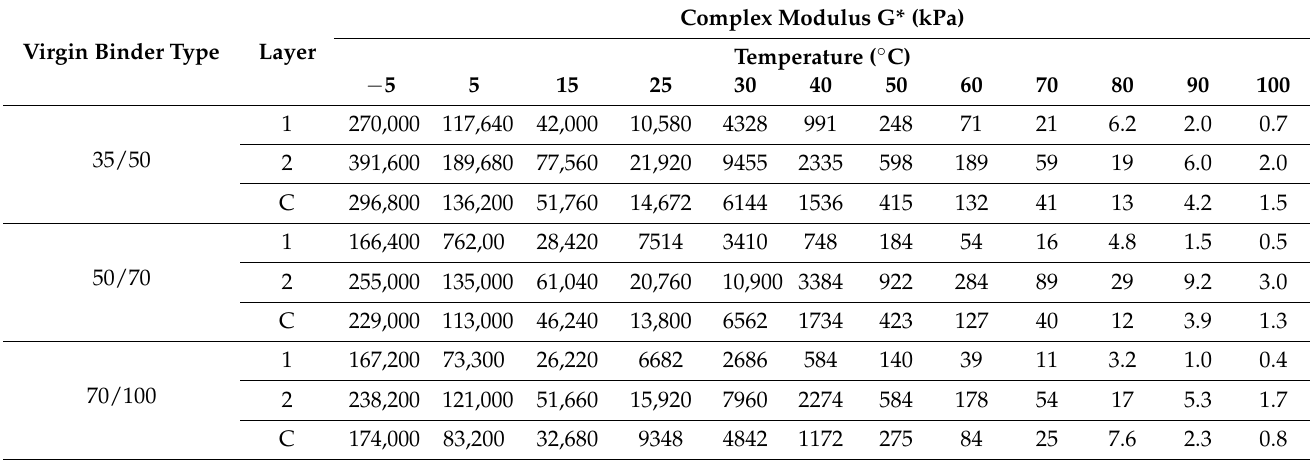
Table 4. Complex shear modulus G* of the paving bitumens as a virgin binder.